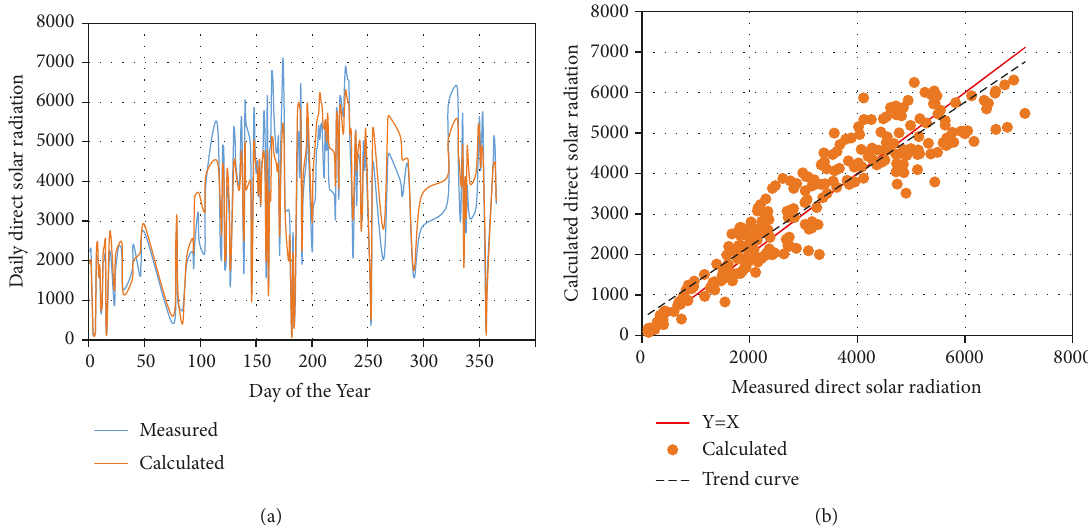
Figure 3: Comparison between measured and estimated direct radiation values. Table 7: Errors obtained according to clarity index using Rabat